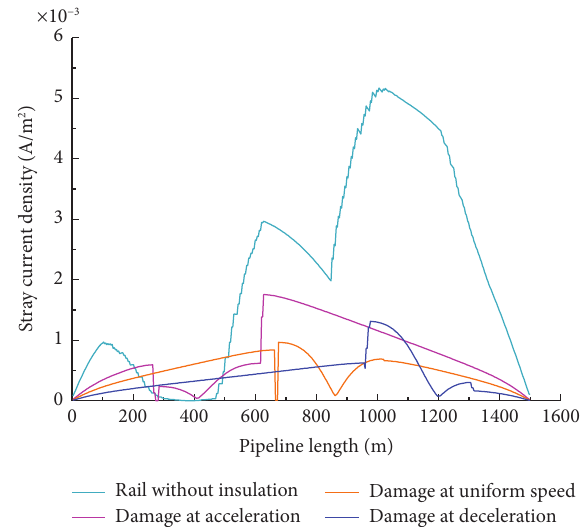
Figure 13: Corrosion of buried pipelines in train operation